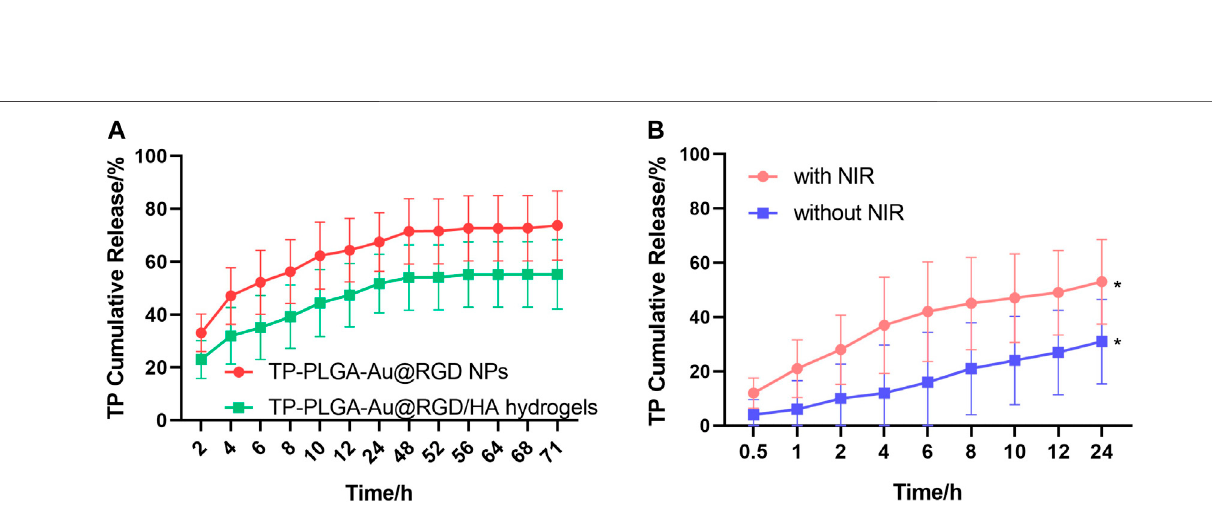
FIGURE5|(A) Pro fi lesofTPreleasefromTP-PLGA-Au@RGD/HA hydrogelsandTP-PLGA-Au@RGDNPsunderinitialNIRirradiationfor10 min. (B) Pro fi lesofTP release from TP-PLGA-Au@RGD/HA hydrogels with or without NIR irradiation for 10 min. Data are expressed as mean values for n = 3, and error bars represent the standard deviation of the means (* p <